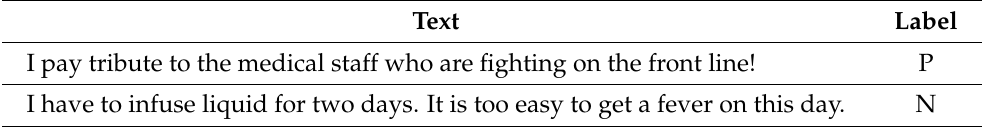
Table 1. Specific cases of emotional polarity label.